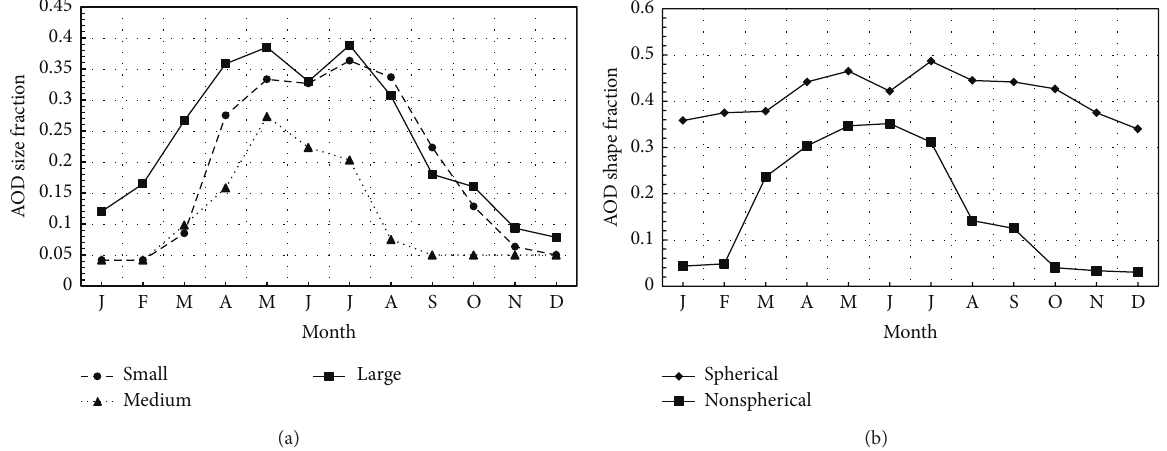
Figure 11: Climatology of AOD shape fraction and size over region 3 using MISR Level 3 at 558 nm (green band) (2003–2013): (a) size and (b) shape.